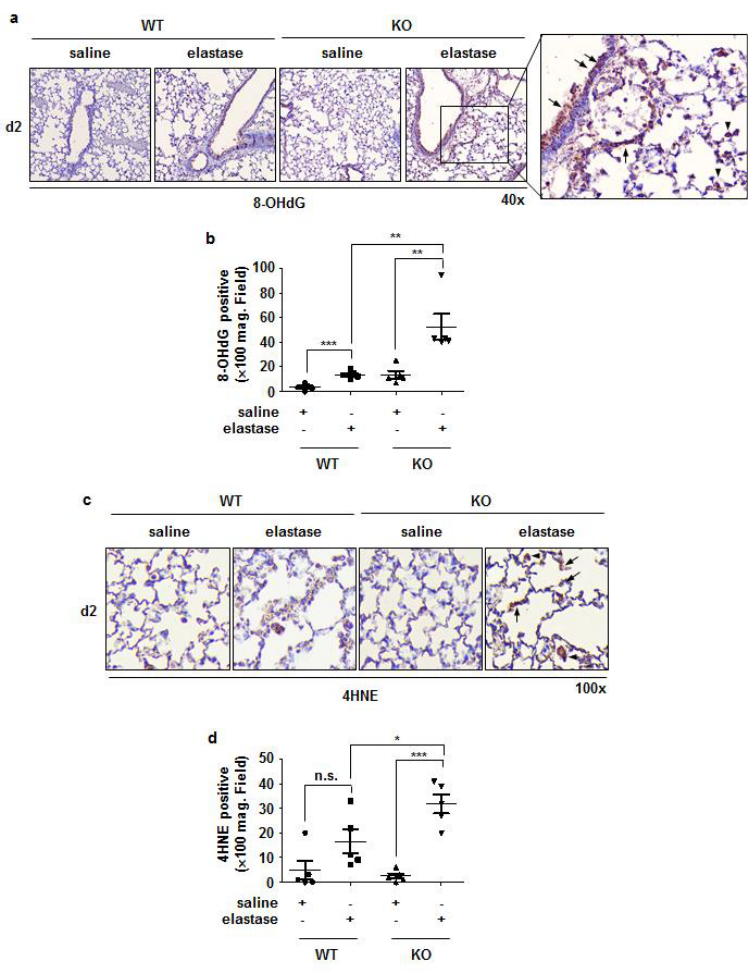
Figure 6. Crbn KO increased elastase-induced oxidative damage. WT and Crbn KO mice were given 0.5 units elastase via intratracheal injection. (Day 2: WT-saline n = 5, WT-elastase n = 5, KO-saline n = 5, KO-elastase n = 5). Representative images of 8-OHdG ( a ) and 4HNE ( c ) immunohistochemical staining in lungs from WT and Crbn KO mice on day 2 (d2) after intratracheal instillation of elastase. ( b , d ) Quantity of 8-OHdG positive cells and 4HNE positive cells in ×100 field of the whole group. Data represent the mean ± SE. * p < 0.05, ** p < 0.01, and *** p < 0.001, n.s., not